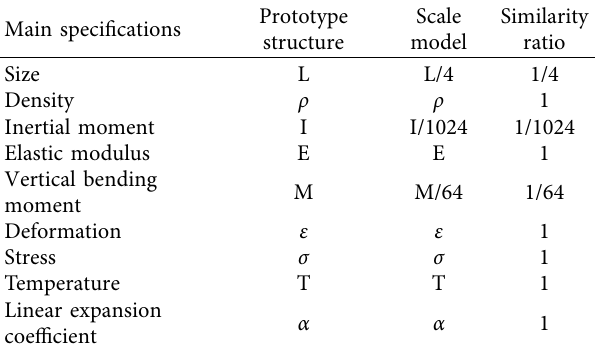
Figure 2: Scaled specimens of the CRTS II ballastless track bridge. (a) Facade view (unit: mm). (b) Top view. Table 1: The similarity ratio of structural parameters in the scaled model.